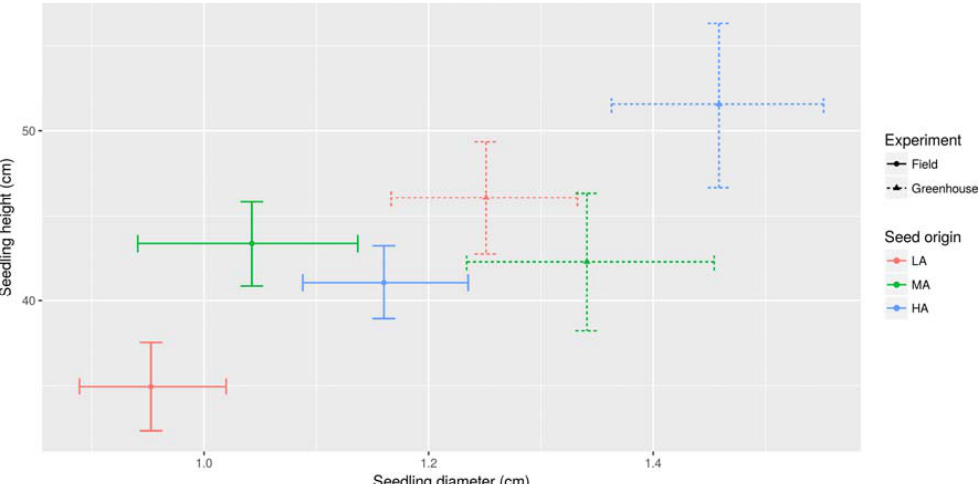
Figure 8. Modeled seedling diameter and seedling height for each seed origin (MA: P. nigra from typical distribution, HA: P. nigra from upland forests distribution, LA: P. nigra from lowland forests distribution), both in the greenhouse and field experiment. The error bars indicate the 95% credible